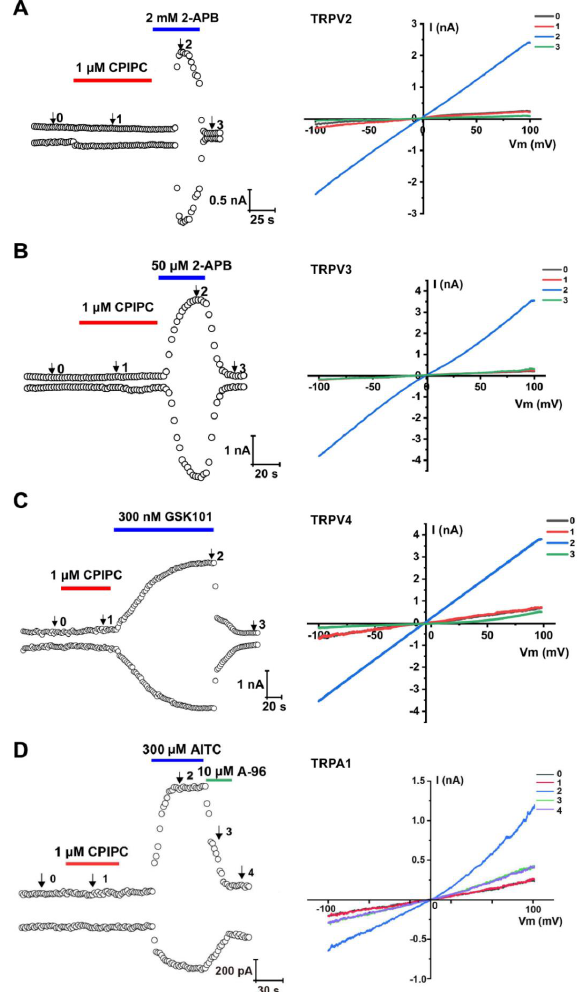
Figure 4. Lack of activation of m TRPV2, h TRPV3, h TRPV4 and h TRPA1 channels expressed in HEK293 cells by CPIPC . ( A ) Left: time courses of whole-cell m TRPV2 currents in response to 1 µ M CPIPC and 2 mM 2-APB (TRPV2 agonist) measured at +100 mV (up) and − 100 mV (down). Right: current-voltage curves of TRPV2 in response to voltage ramps from − 100 to +100 mV under control conditions ( 0 ), addition of 1 µ M of CPIPC ( 1 ), 2 mM of 2-APB ( 2 ) and washout ( 3 ). ( B ) Left: time courses of whole-cell h TRPV3 currents in response to 1 µ M CPIPC and 50 µ M 2-APB (TRPV3 agonist) measured at +100 mV (up) and − 100 mV (down). Right: current-voltage curves of TRPV3 in response to voltage ramps from − 100 to +100 mV under control conditions ( 0 ), addition of 1 µ M of CPIPC ( 1 ), 50 µ M of 2-APB ( 2 ) and washout ( 3 ). ( C ) Left: time courses of whole-cell h TRPV4 currents in response to 1 µ M CPIPC and 300 nM GSK1016790A (TRPV4 agonist) measured at +100 mV (up) and − 100 mV (down). Right: current-voltage curves of TRPV4 in response to voltage ramps from − 100 to +100 mV under control conditions ( 0 ), addition of 1 µ M of CPIPC ( 1 ), 300 nM GSK1016790A ( 2 ) and washout ( 3 ). ( D ) Left: time courses of whole-cell h TRPA1 currents in response to 1 µ M CPIPC , 300 µ M AITC (TRPA1 agonist) and 10 µ M A967079 (TRPA1 antagonist) measured at +100 mV (up) and − 100 mV (down). Right: current-voltage curves of TRPA1 in response to voltage ramps from − 100 to +100 mV under control conditions ( 0 ), addition of 1 µ M of CPIPC ( 1 ), AITC ( 2 ), A967079 ( 3 ) and washout ( 4